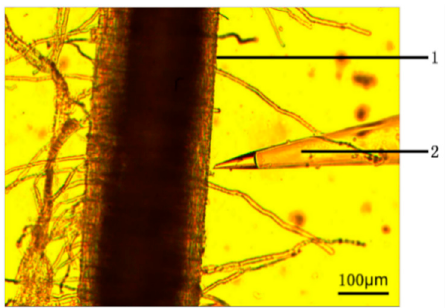
Figure 2. Typical microscopy image of biological experiment. 1. Wheat root; 2. ISME.